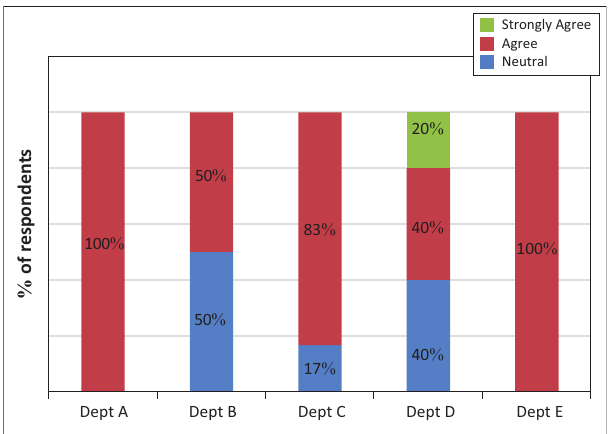
FIGURE 9: Better insight.